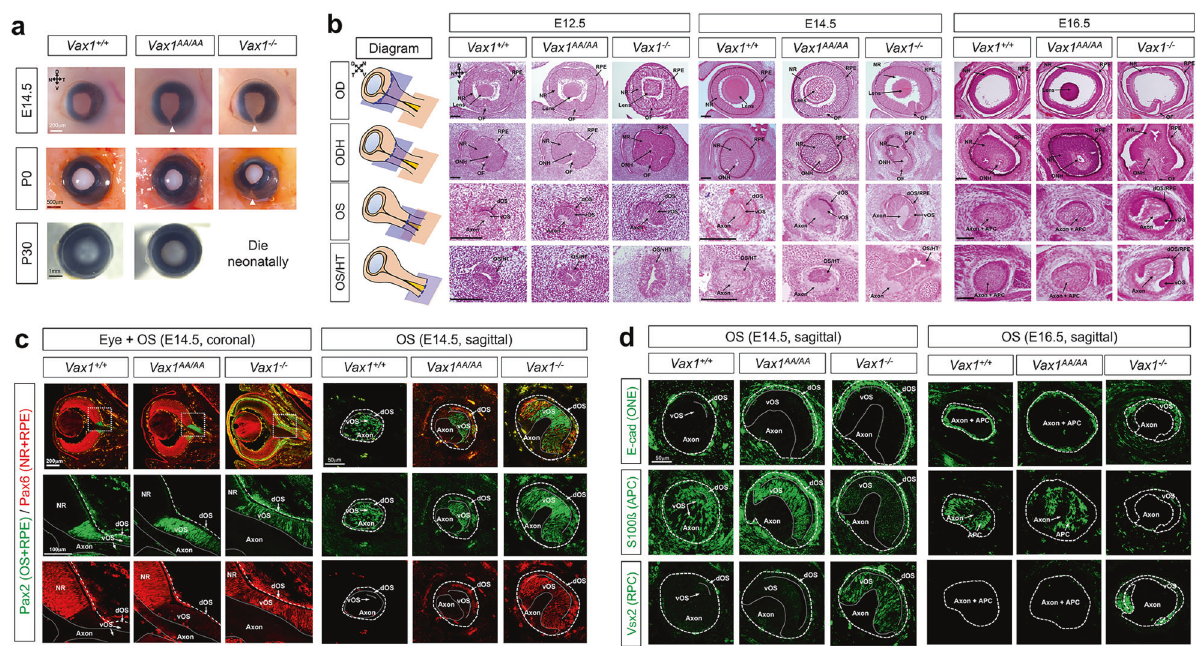
Fig. 3 Developmental delay of OS differentiation in Vax1 AA/AA mice. a Pictures of mouse eyes (frontal view) with the indicated genotypes are taken at various developmental stages. Arrowheads point to the optic fi ssures. N, nasal; T, temporal; D, dorsal; V, ventral. b Sagittal sections of mouse embryos were stained with hematoxylin & eosin (H&E). Positions of the sections are indicated by blue plates in the diagram (leftmost column). APC, astrocyte precursor cell; ODH, optic disc head; OF, optic fi ssure; dOS, dorsal optic stalk; vOS, NR, neural retina; RPE, retinal pigment epithelium; ventral optic stalk; vHT, ventral hypothalamus. Scale bars in the pictures are 100 μ m. c The distributions of Pax6 and Pax2 in E14.5 mouse embryonic sections were examined by immunostaining. Boxed areas in top row images of coronal sections are magni fi ed in two bottom rows. d Sagittal sections including the medial OS of E14.5 and E16.5 mouse embryos were stained with antibodies that recognize the corresponding markers. APC, astrocyte precursor cell; ONE, optic neuroepithelium; RPC, retinal progenitor